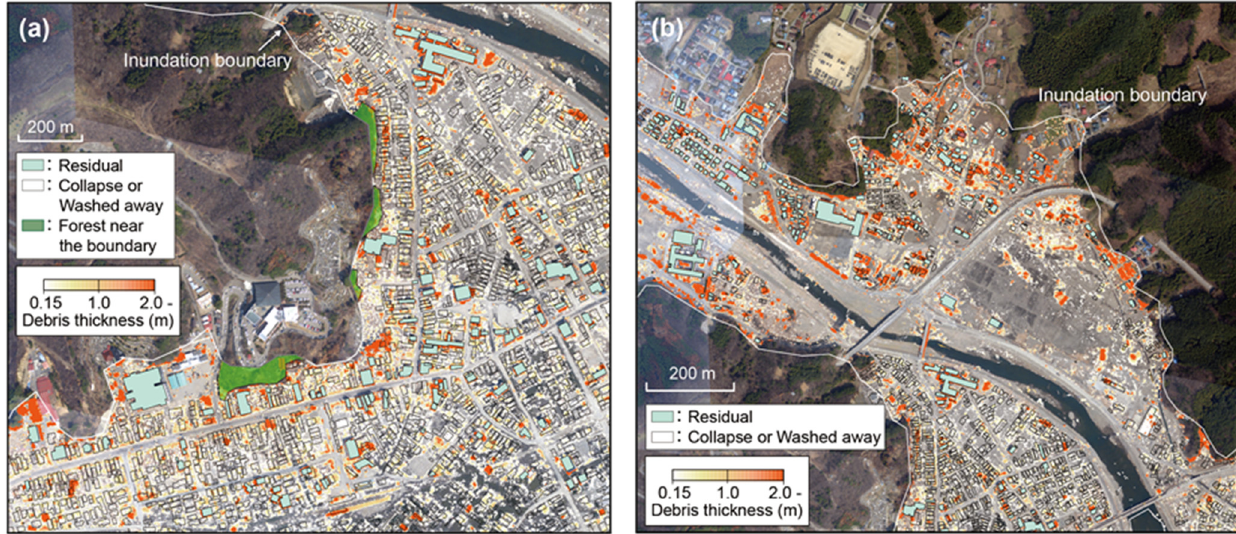
Figure 3. The distribution of tsunami debris in Otsuchi area A, estimated by using a DSM and a DEM with 1 m resolution. ( a ) An example showing the corrected positions of buildings after the removal of trees at the inundation boundary. ( b ) The corrected tsunami debris thickness distribution estimated from the difference between the DSM and DEM. Each figure from Imai et al. [6].